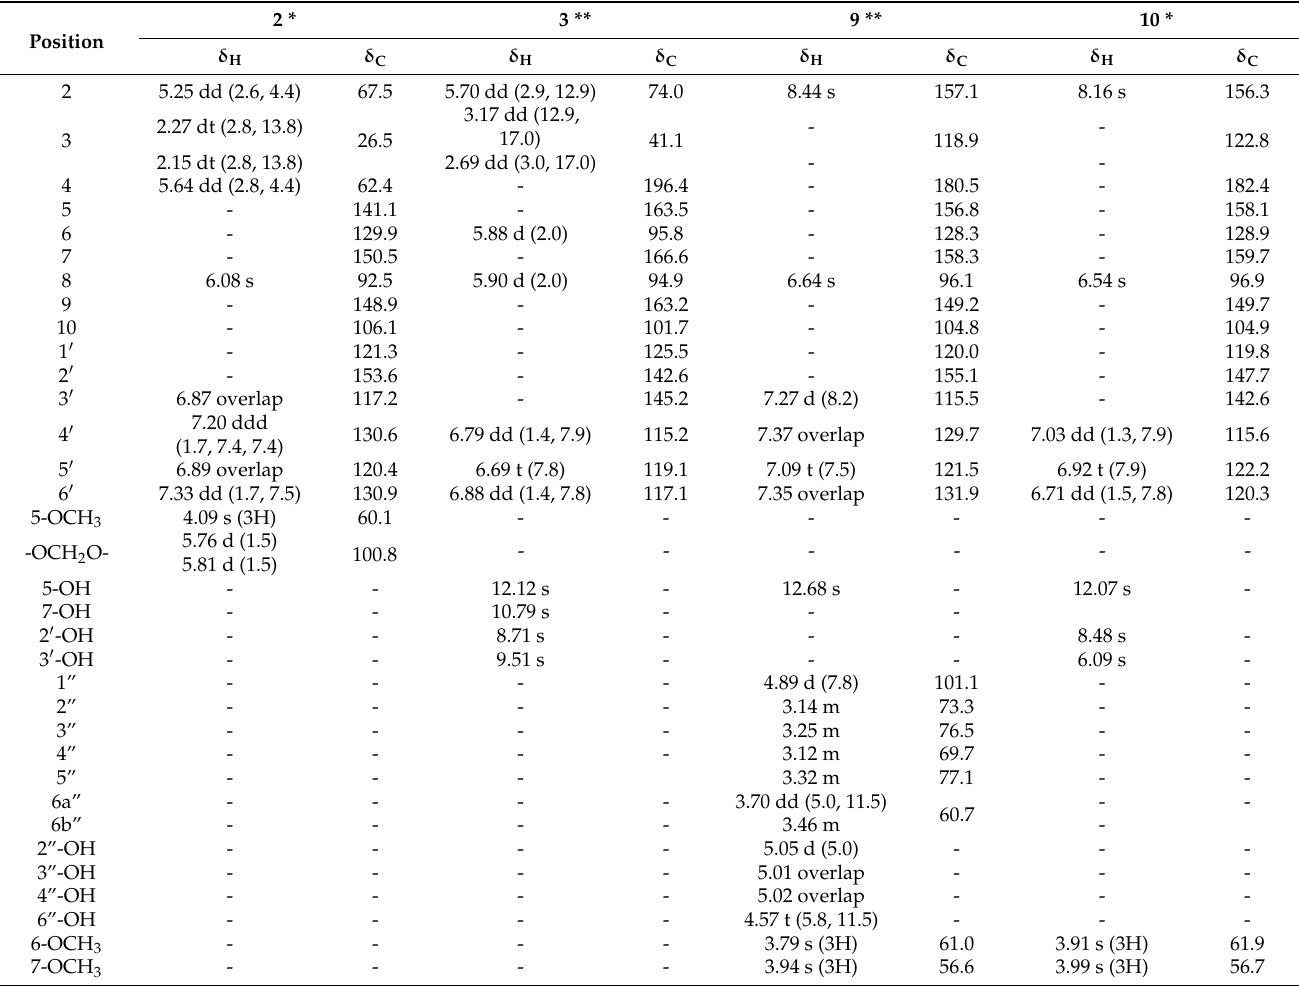
Table 2. 1 H NMR (500 MHz) and 13 C NMR (125 MHz) data of compounds 2 , 3 , 9 , and 10 ( δ in ppm, J in